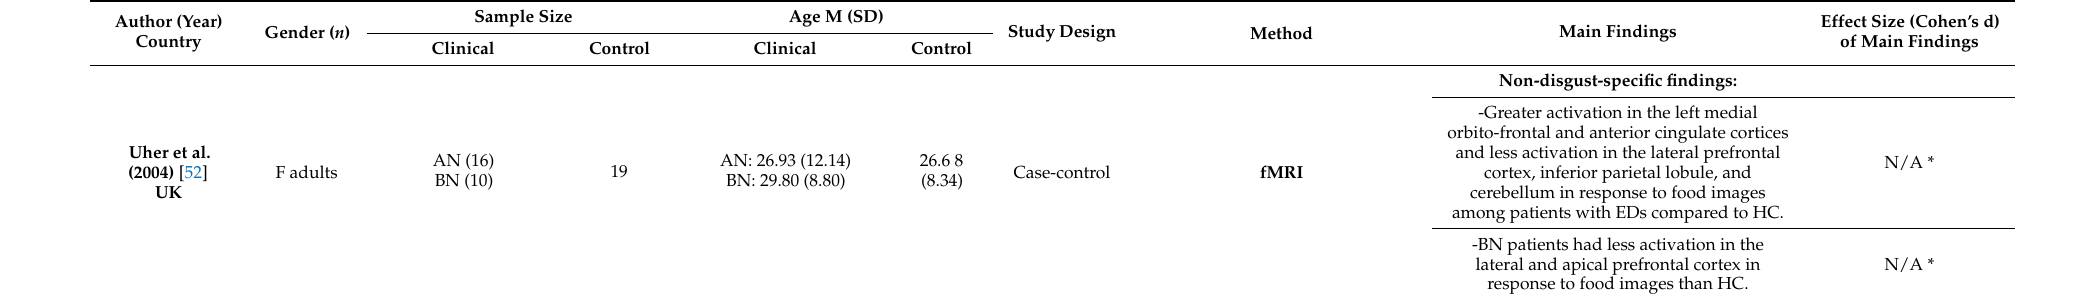
Table 4. A summary of brain imaging and neurophysiological studies of